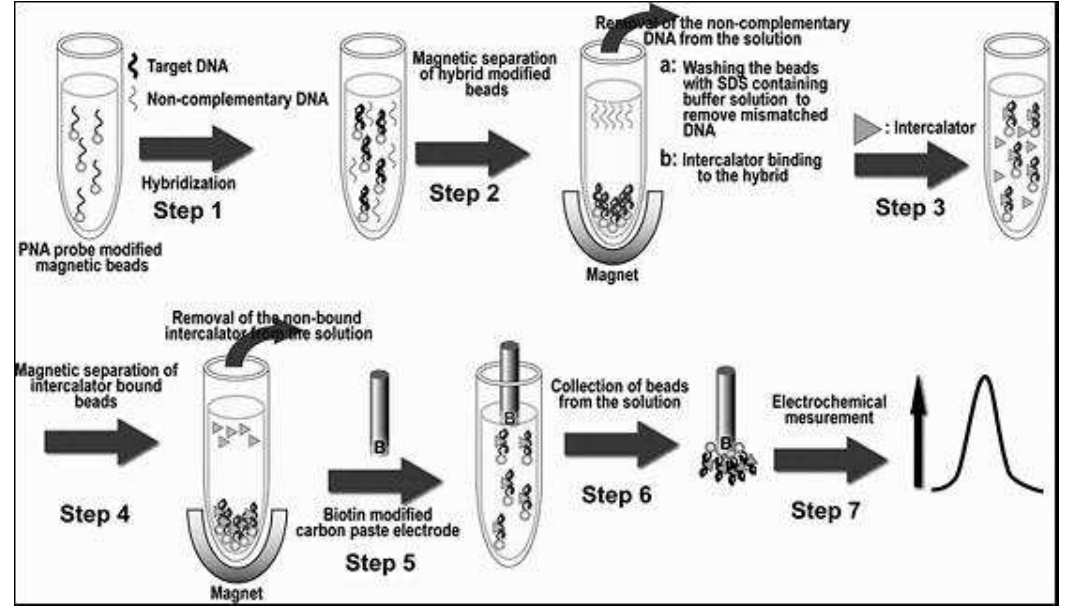
Figure 5. Procedure of the genomagnetic bioassay ( Reprinted from [18] with permission from Elsevier